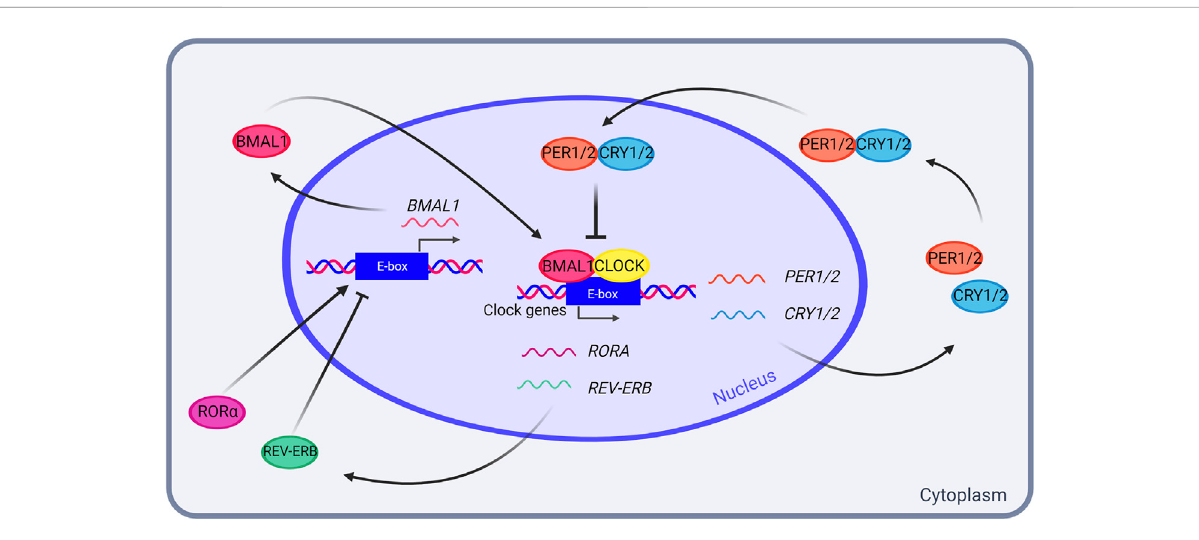
FIGURE 1 The mammalian transcriptional-translational feedback loop (TTFL). In the mammalian TTFL, transcription activators CLOCK and BMAL1 bind to the E-boxes in PER1/2 and CRY1/2 promoters, resulting in their transcription. PER1/2 and CRY1/2 accumulate in the cytoplasm, and form a heterodimer that enters the nucleus and inhibits the CLOCK-BMAL1 complex, thus inhibiting their own transcription in a feed-forward negative loop. In addition, CLOCK and BMAL1 also promote RORA and REV-ERB transcription, which in turn activate and inhibit BMAL1 transcription, respectively. Created with